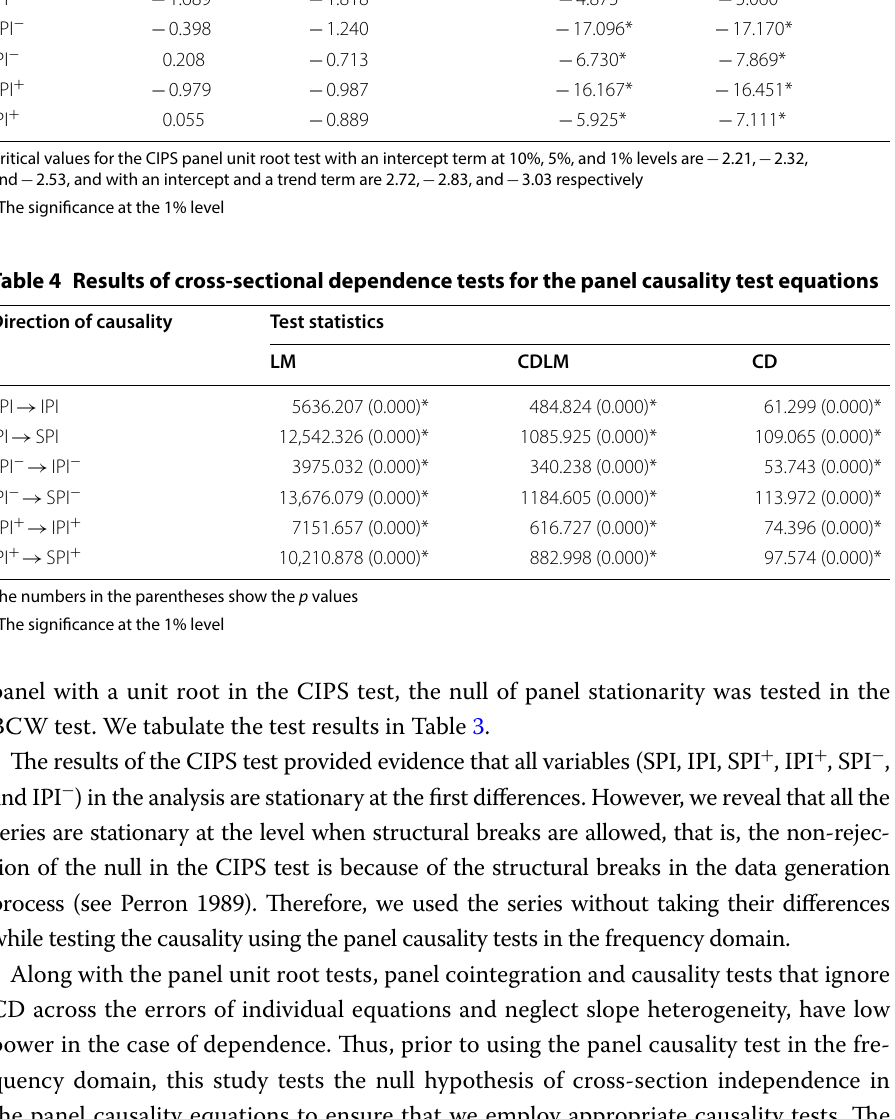
Table 3 Results of CIPS panel unit root test